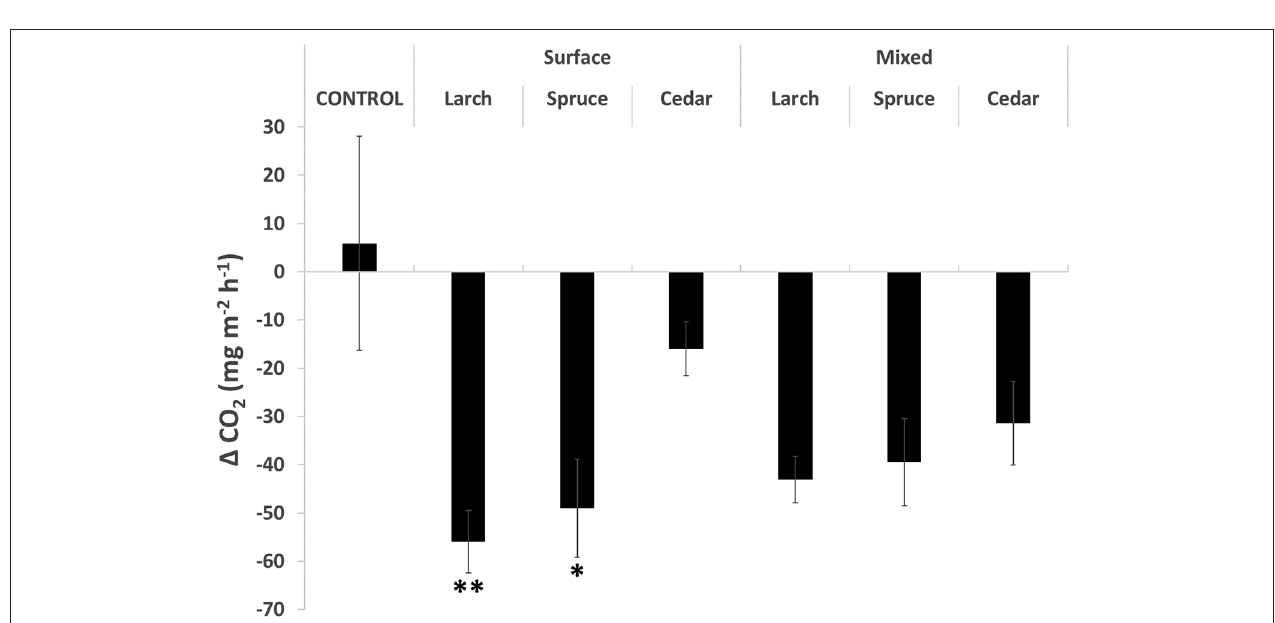
FIGURE 3 | Mean change in CO 2 flux over the period September 2013 to July 2014 ( n = 5). Significance levels: * p < 0.05, ** p <